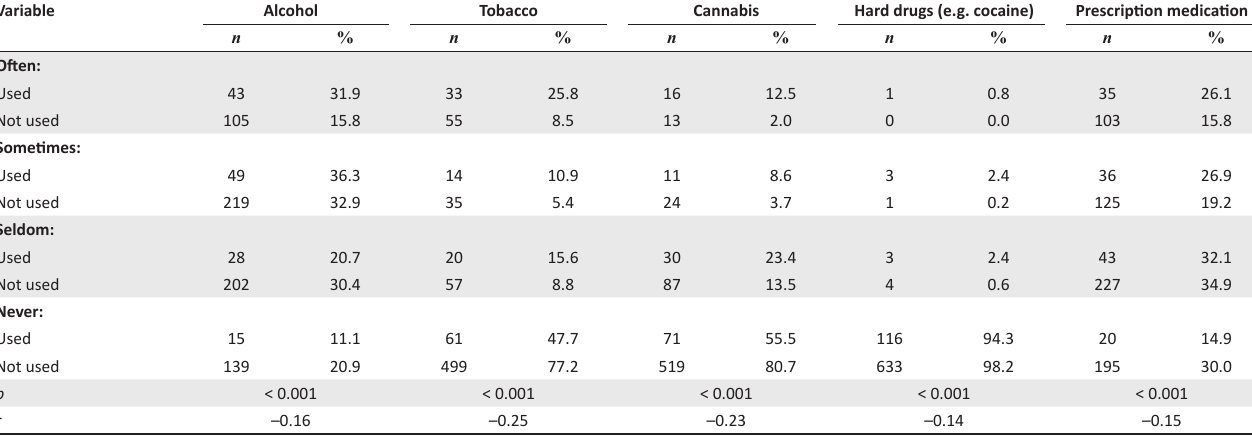
TABLE 3: Methylphenidate use and frequency of use of other substances.